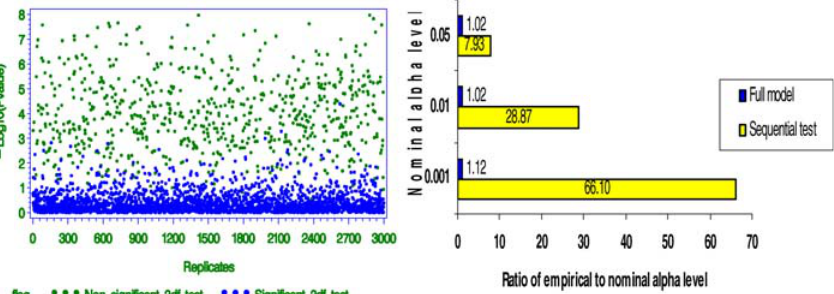
Figure 3. Effect of ‘‘ Conditional Conditioning ’’ on Type 1 Error Rates We simulated datasets containing a phenotype Y that is associated with a marker G 1 and true ancestry. We also simulated another marker G 2 that is not associated with Y, but like Y, is correlated with true ancestry. Therefore, any significant association between Y and G 2 is considered a false positive. We consider the full model Y ¼ b 0 þ b 1 A i þ b 2 P 1 i P 2 i þ b 3 G 2 þ e i . We begin by testing the null hypothesis H 0 : b 1 ¼ 0 and b 2 ¼ 0. If this test is significant, the p- value represented by the blue dots is obtained from the full model, otherwise we obtained the p value (green dots in the graph) from the restricted model Y ¼ b 0 þ b 3 G 2 þ e i . As can be seen, p values tend to be quite small when we do not include the nonsignificant terms in the final model. The bar graphs on the right hand side show the type I error inflation (yellow bars) when one tests for association between Y and g 2 in a sequential fashion; that is by first testing H 0 : b 1 ¼ 0 and b 2 ¼ 0, and relying on the outcome of this test to decide whether to control for ancestry. The correct a levels are obtained by always including ancestry terms in the model regardless of their levels of